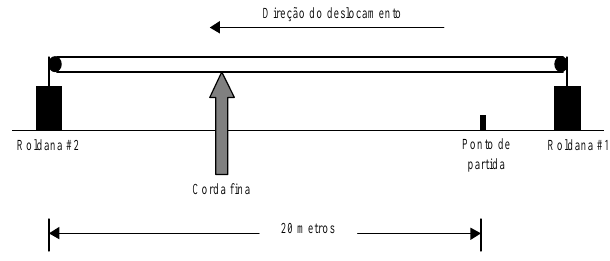
Figura 1. Representa(cid:231)ªo esquemÆtica do sistema de roldanas utilizado no presente